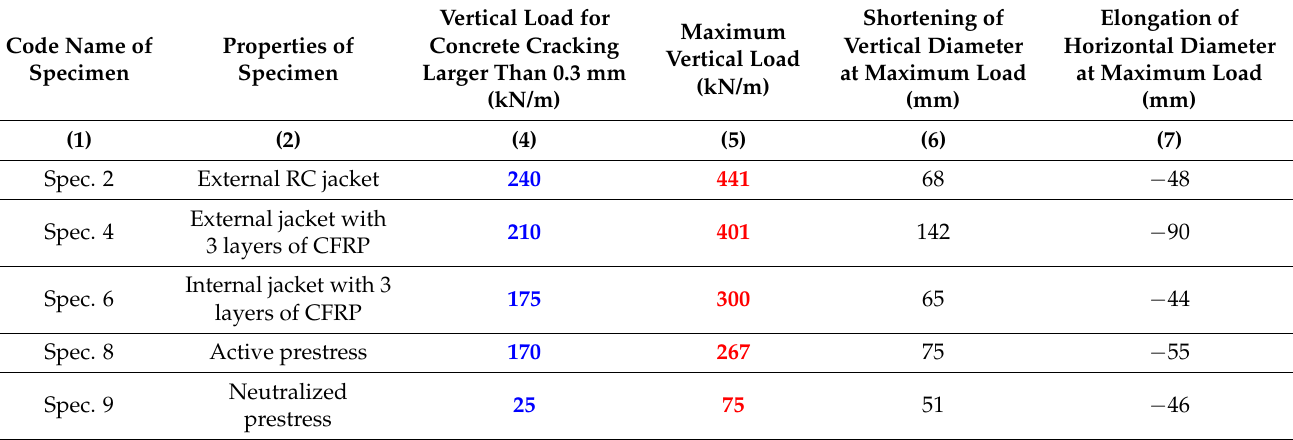
Figure 12. Summary of the measured load–displacement response obtained during 3EB-ASTM:C497 M-17 testing. Table 3. Measured extreme values obtained during 3EB-ASTM:C497 M-17